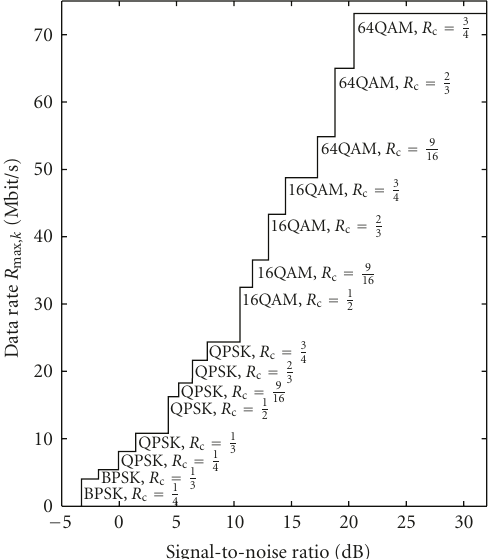
Figure 6: Adaptive modulation: relation between instantaneous data rate and signal-to-noise ratio (SNR).